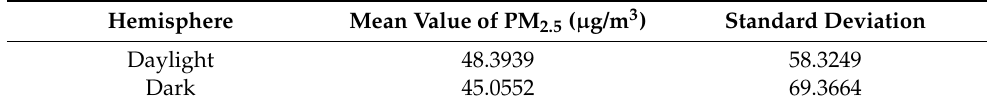
Table 1. PM 2.5 concentrations with different hemispheres.